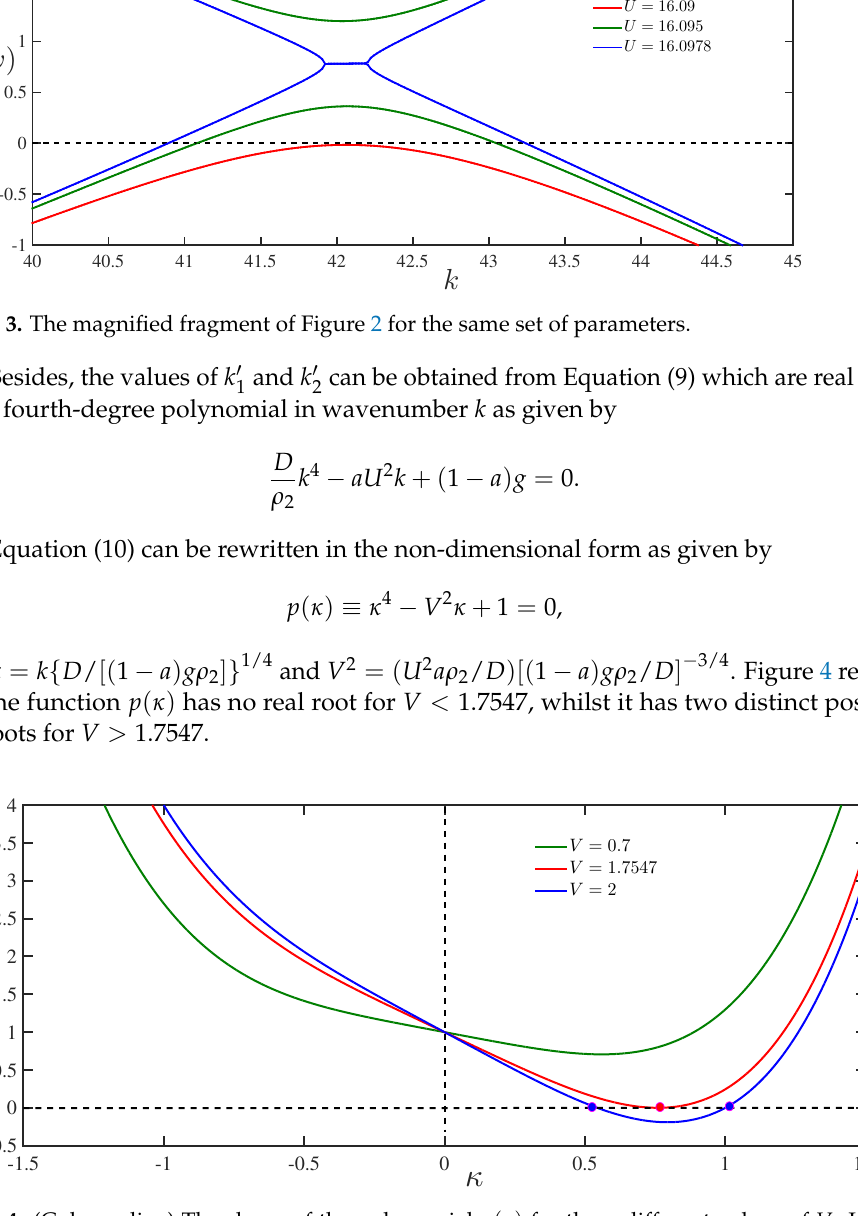
Figure 4. (Color online) The shape of the polynomial p ( κ ) for three different values of V . Line 1, V = 0.7,—no real roots; line 2, V = 1.7547,—there is one double root (designated by red dot); line 3, V = 2.0,—there are two real roots (designated by blue